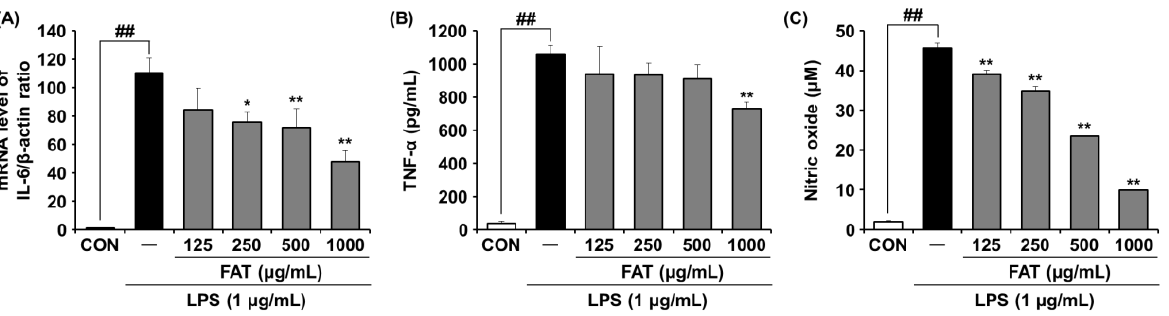
Figure 4. Effects of FAT on the mRNA expression of IL-6 and the pro-inflammatory mediator produc- tion in LPS-induced RAW264.7 cells. ( A ) IL-6 was determined by RT-PCR. ( B ) TNF- α and ( C ) NO production were measured by using ELISA. Data represent the mean ± SD of three independent experiments. Statistical significance was assessed by one-way ANOVA followed by Tukey’s